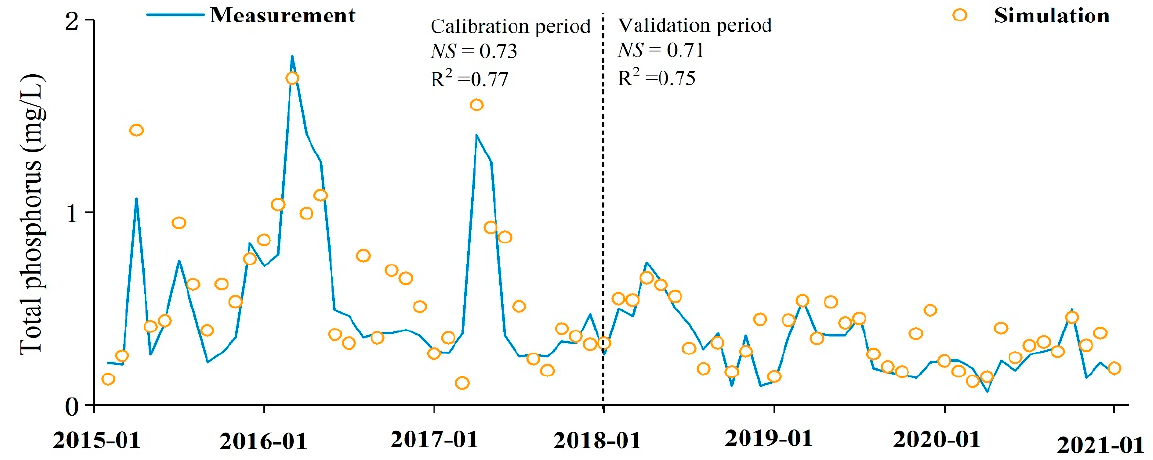
Figure 9. Comparison of total phosphorus concentration determination and validation.